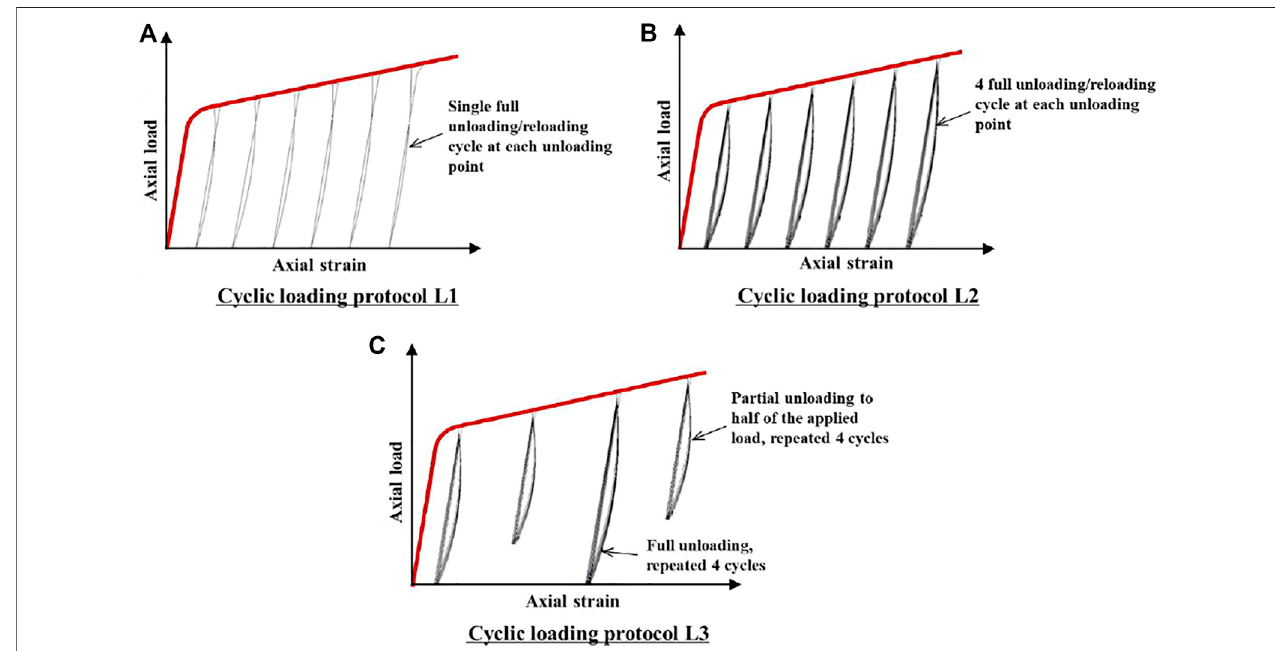
FIGURE 2 | Cyclic loading protocols. (A) Cyclic loading protocol L1. (B) Cyclic loading protocol L2. (C) Cyclic loading protocol L3.